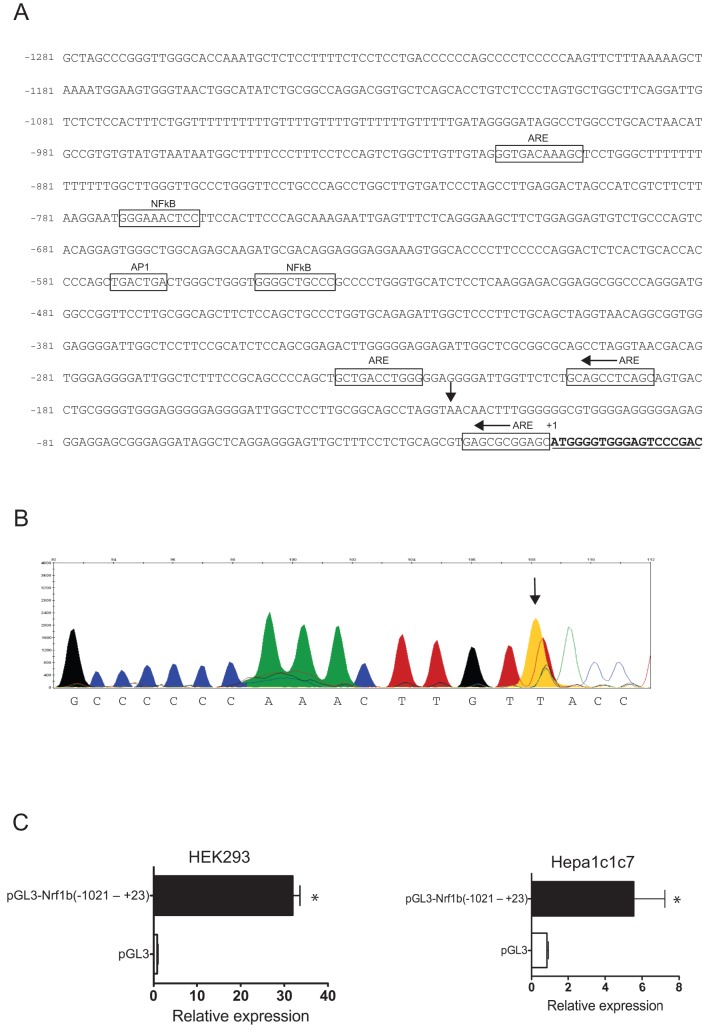
Nrf1b is derived by alternative promoter usage.(A). Nucleotide sequence and identification of putative cis-acting elements in the 5′-flanking region of Nrf1b exon 1. Numbering is relative to the first nucleotide of the initiation codon (ATG) designated as +1. Vertical arrow represents the transcription start site identified by primer extension analysis, and coding region is underlined. The cis-acting elements containing consensus sequences are boxed. (B). Primer extension result with NIH3T3 mRNA. The peak corresponding to a 108-bp elongation product (FAM-labeled cDNA) is indicated by an arrow. Labeled cDNA was aligned with the sequence electropherogram to identify the base at which transcription starts for Nrf1b. Nucleotides are indicated on the x-axis. (C). Relative luciferase activities of the mouse Nrf1b promoter construct in HEK293 and Hepa1c1c7 cells. Negative control consisted of the pGL3-Basic control. Luciferase activities were normalized to Renilla luciferase from pRL-TK. Histograms show mean ± SD of three independent experiments with triplicate samples per experiment. *P<0.05.